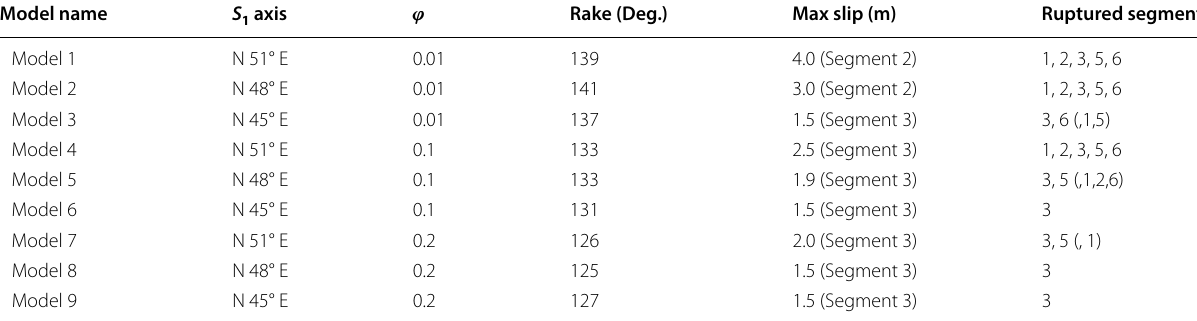
For the max slip, the segment on which the slip occurs is also displayed. For the ruptured segment, segments put in parentheses are ruptured